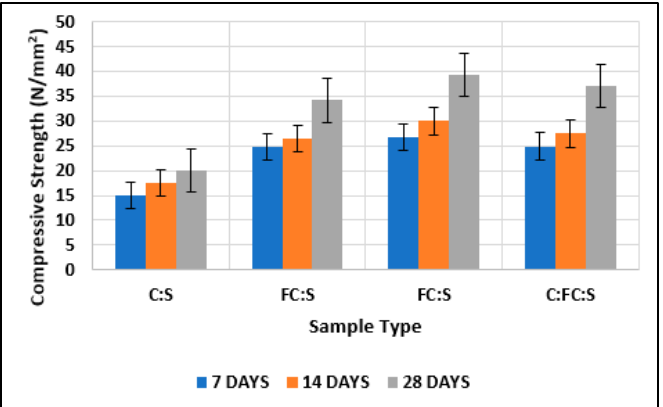
Figure 13. Comparison of test results of cubes with cement and fine cement.